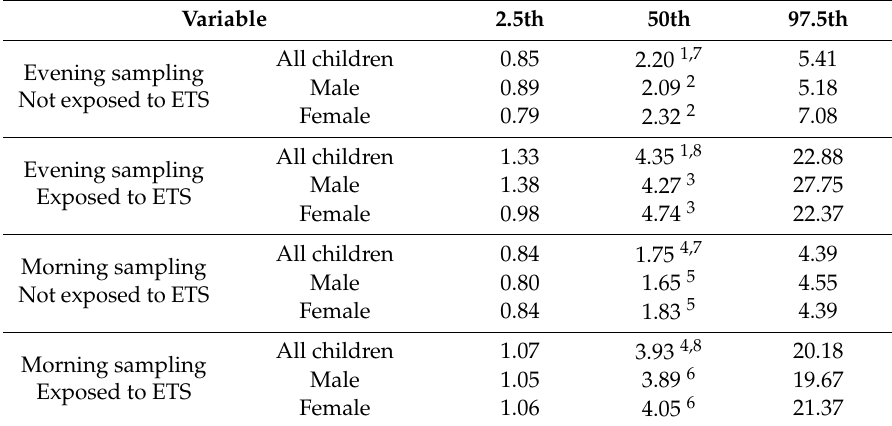
Table 3. Reference values of urinary cotinine levels (expressed as µ g g − 1 creatinine) for children not exposed and exposed to Environmental Tobacco Smoke (ETS) calculated for all participants and according to